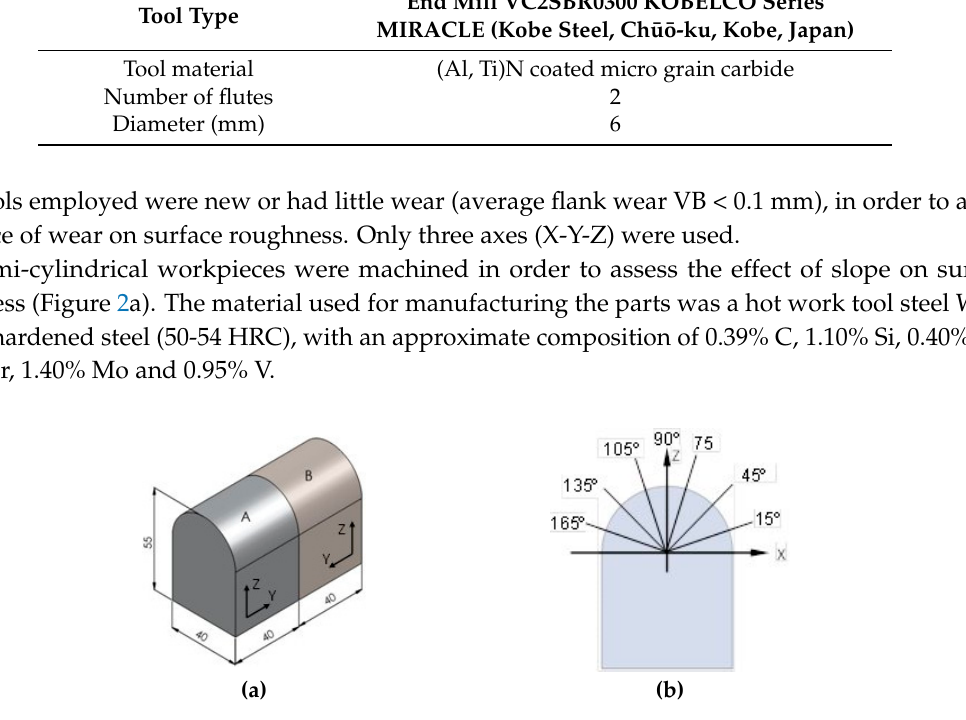
Figure 2. Schematic drawing of ( a ) machined workpiece (units in mm), ( b ) measured position angles.